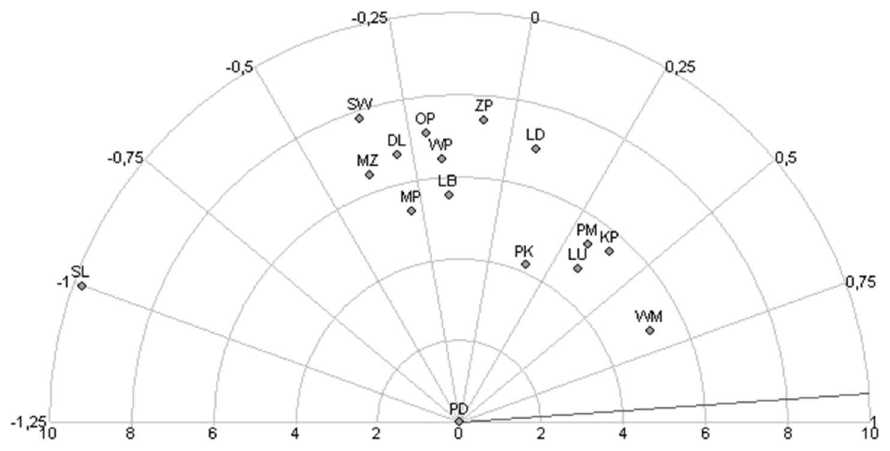
Figure 1. The map for ‘The Podlaskie Voivodeship’ object – a synthetic index JS